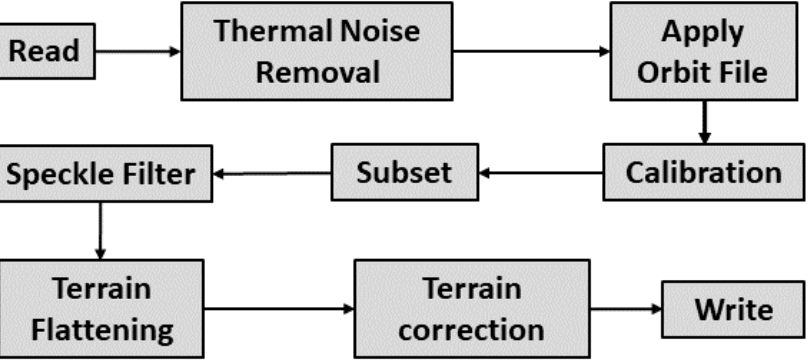
Figure 3. ESA preprocessing workflow for the Sentinel-1 data.